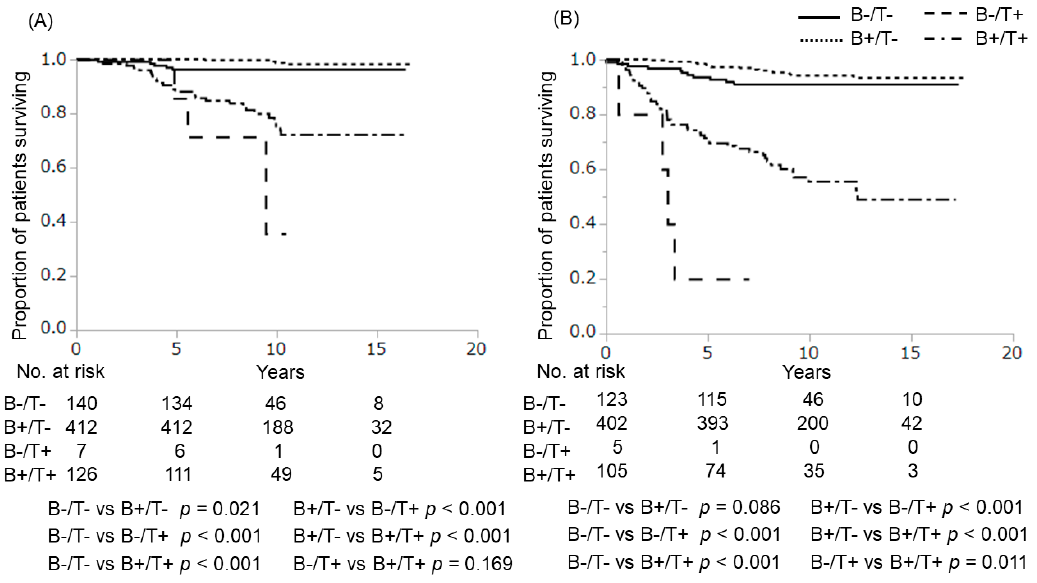
Figure 3. Cause-specific and disease-free survival curves for patients with TERT promoter mutations alone, BRAF mutation alone, both mutations and neither mutation. ( A ) Cause-specific survival; ( B ) disease-free survival. B + , BRAF V600E mutation-positive; B − , BRAF V600E mutation-negative; T + , TERT promoter mutation-positive; T − , TERT promoter mutation-negative. Table 2. Cox proportional hazard regression analysis of genetic mutation status associated with outcomes.